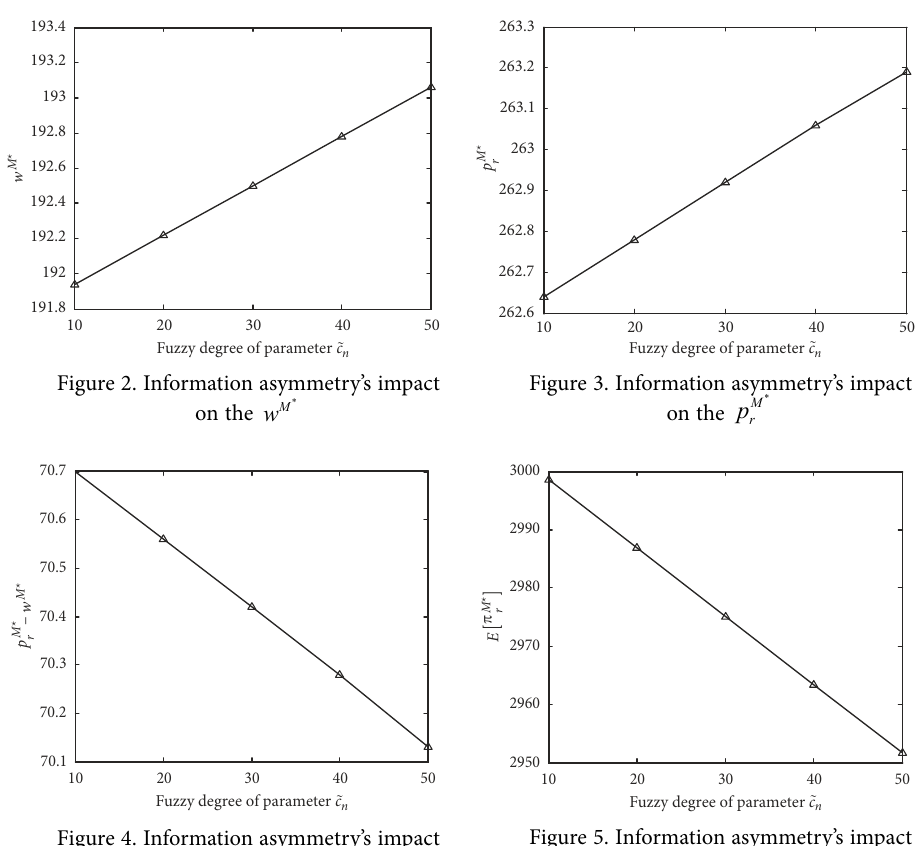
Figure 4. Information asymmetry’s impact on the